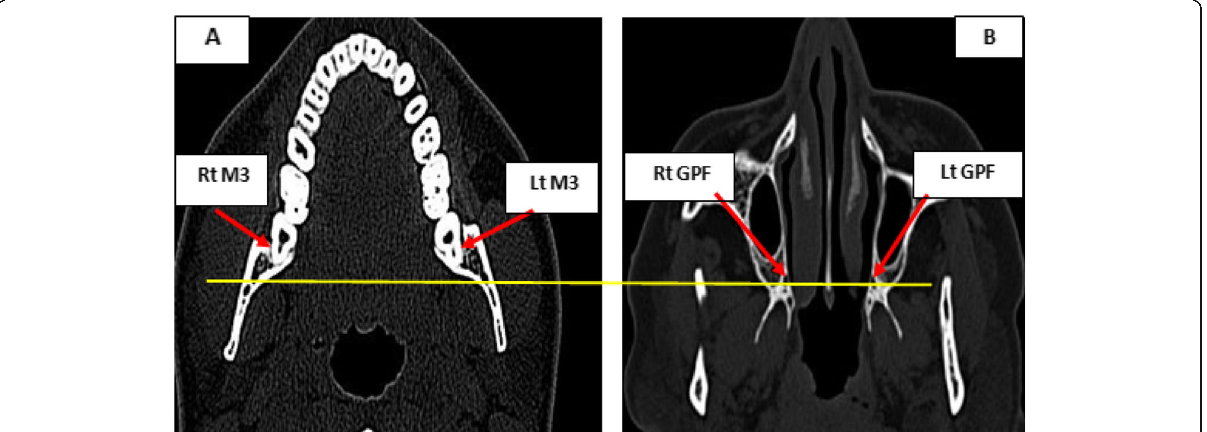
Fig. 3 A CT scan at the region of hard palate illustrating the right and left greater palatine foramina ( b ) located behind the right and left third maxillary molars (M3) ( a